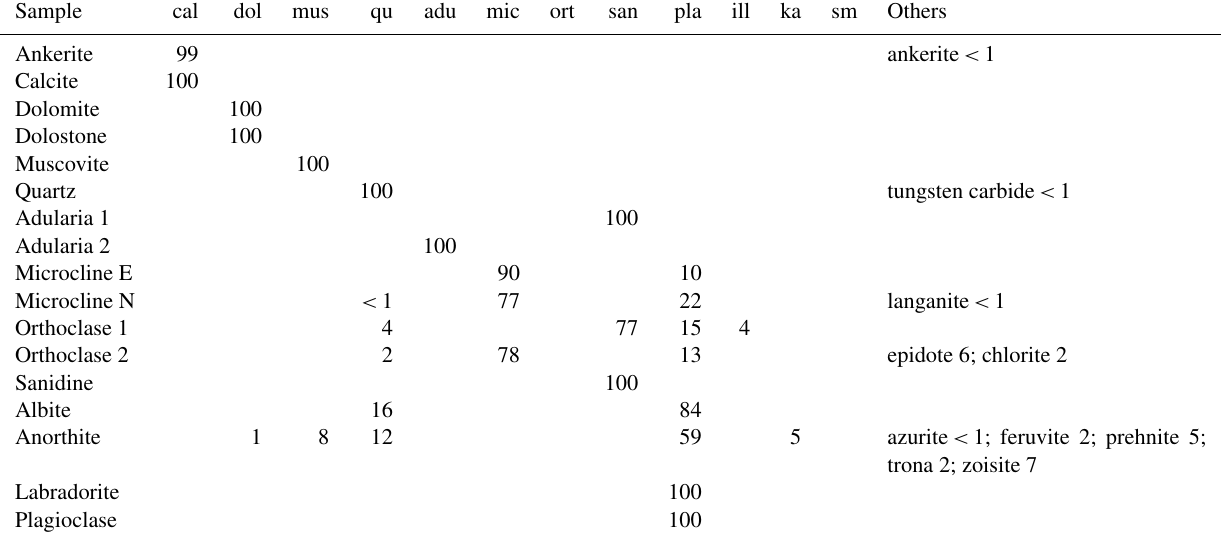
Table 4. Mineralogical composition of reference samples in wt%. The abbreviations stand for cal: calcite; dol: dolomite; mus: muscovite; qu: quartz; adu: adularia; mic: microcline; ort: orthoclase; san: sanidine; pla: plagioclase; ill: illite; ka: kaolinite; sm: smectite